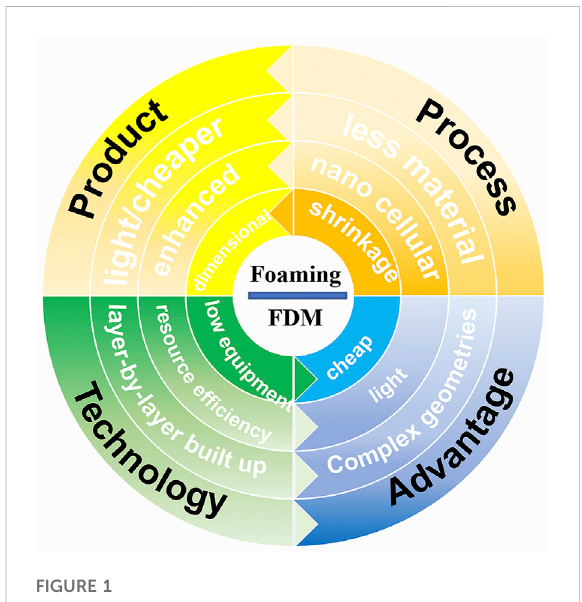
FIGURE 1 The huge advantages of the combination of additive manufacturing and foaming are expected to make it an epoch- making manufacturing